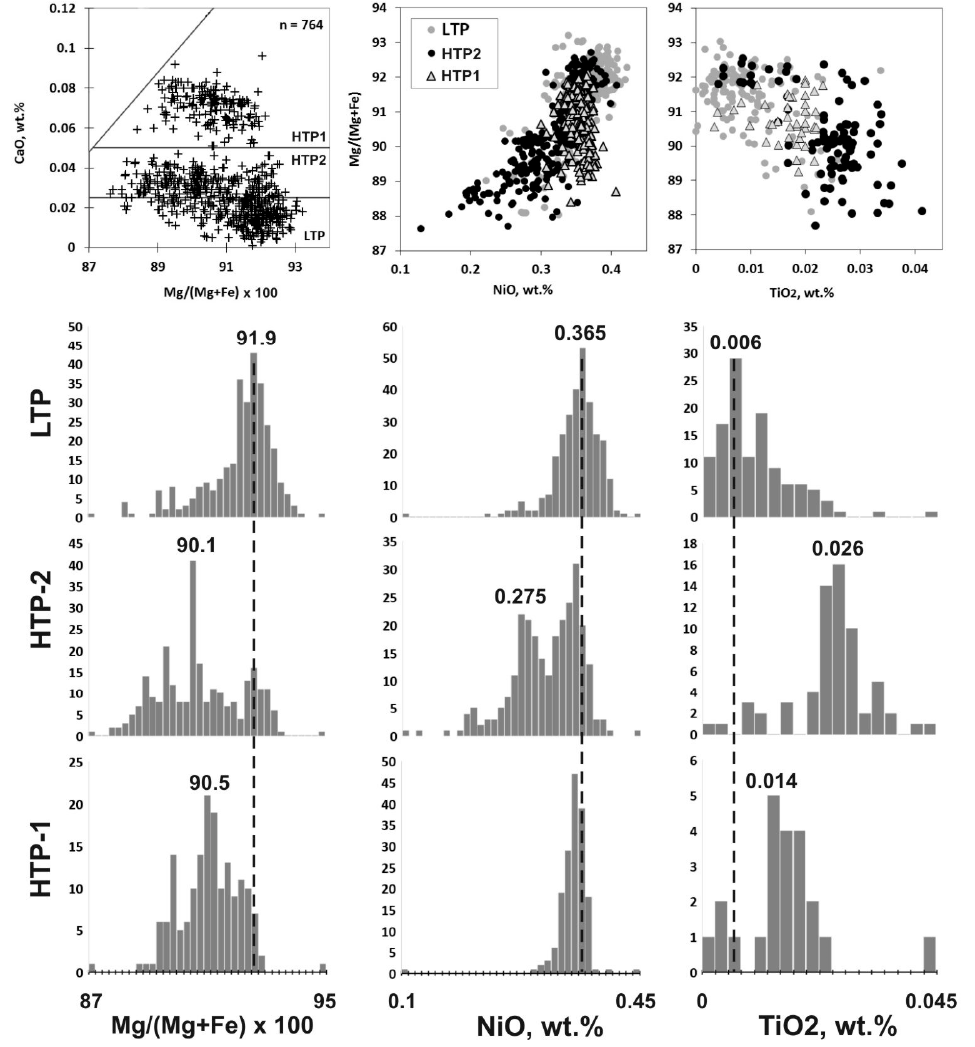
Figure 7. Distribution of some major oxides in olivines of different types. Olivine types: open circles = MCA, gray circles = LTP, black circles = HTP-2, triangles = HTP-1. Scale spacing in histograms: 0.2 for Mg/(Mg + Fe) × 100, 0.01 wt.% for NiO, and 0.0025 wt.% for TiO 2 . Dashed lines mark peak values in low-temperature peridotites (LTP) corresponding to depleted compositions.